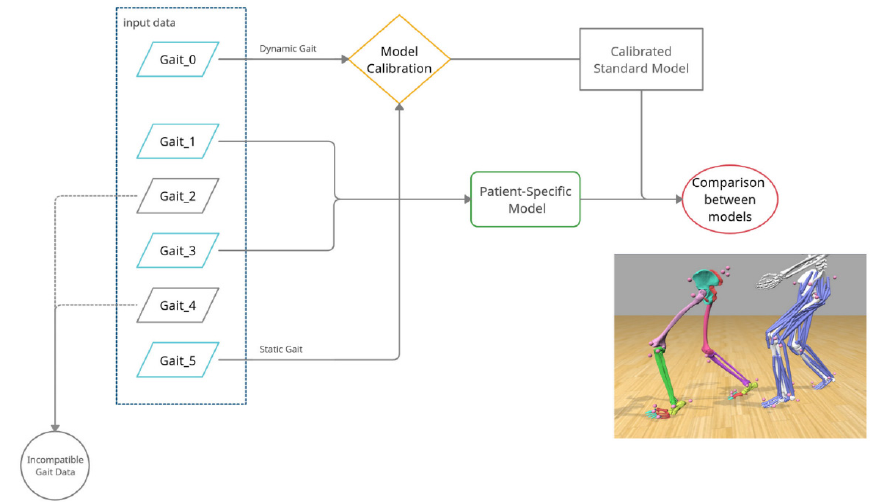
Figure 8. Flowchart of comparison between standard and custom model.